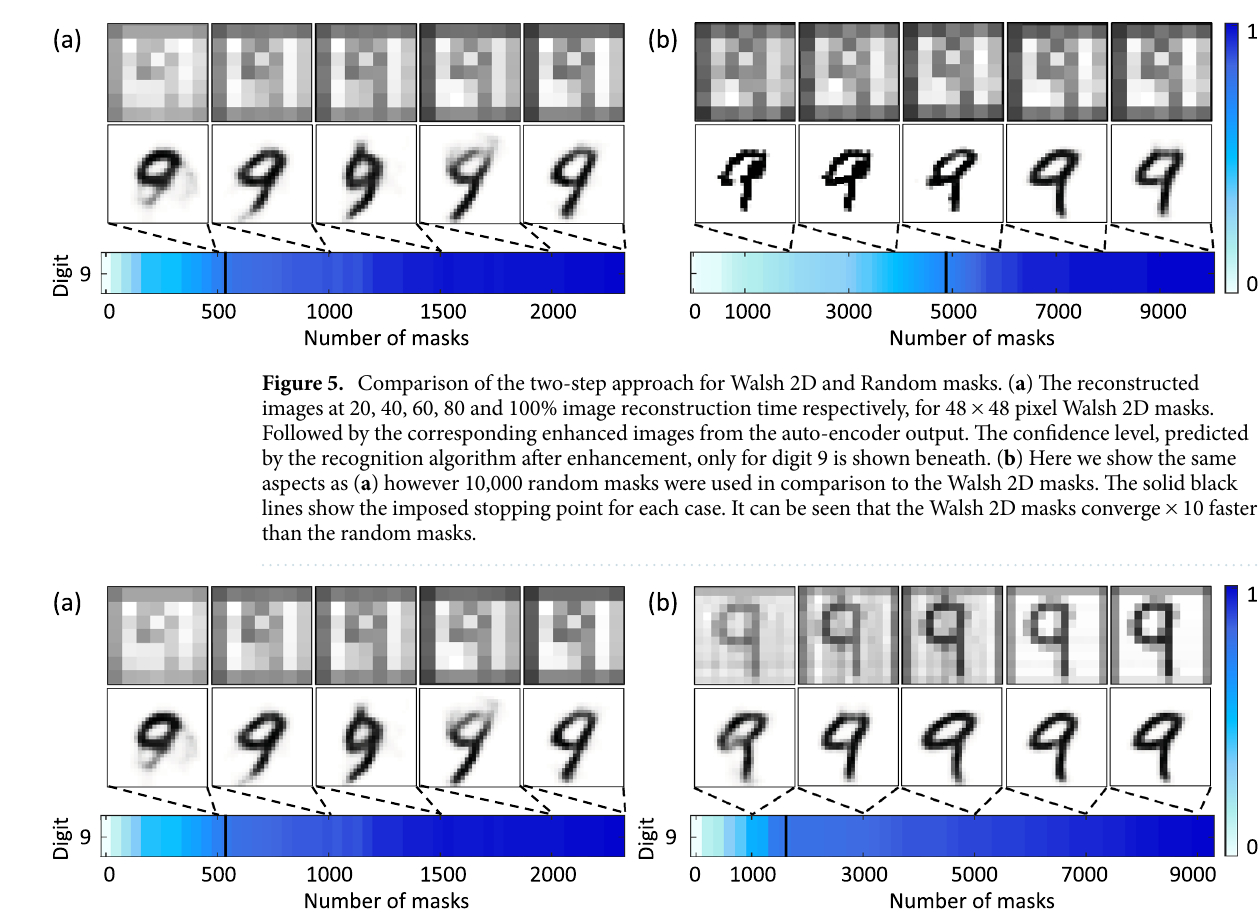
Figure 6. Comparison of the two step approach for different resolutions of the Walsh 2D masks. ( a ) The reconstructed images at 20; 40; 60; 80 and 100% image reconstruction time respectively, for 48 × 48 pixel Walsh 2D masks. Followed by the corresponding enhanced images from the auto-encoder output. The confidence level, predicted by the recognition algorithm after enhancement, only for digit 9 is shown beneath. ( b ) Similarly for 96 × 96 pixel Walsh 2D masks. The solid black lines show the imposed stopping point for each case at around 20% of image acquisition